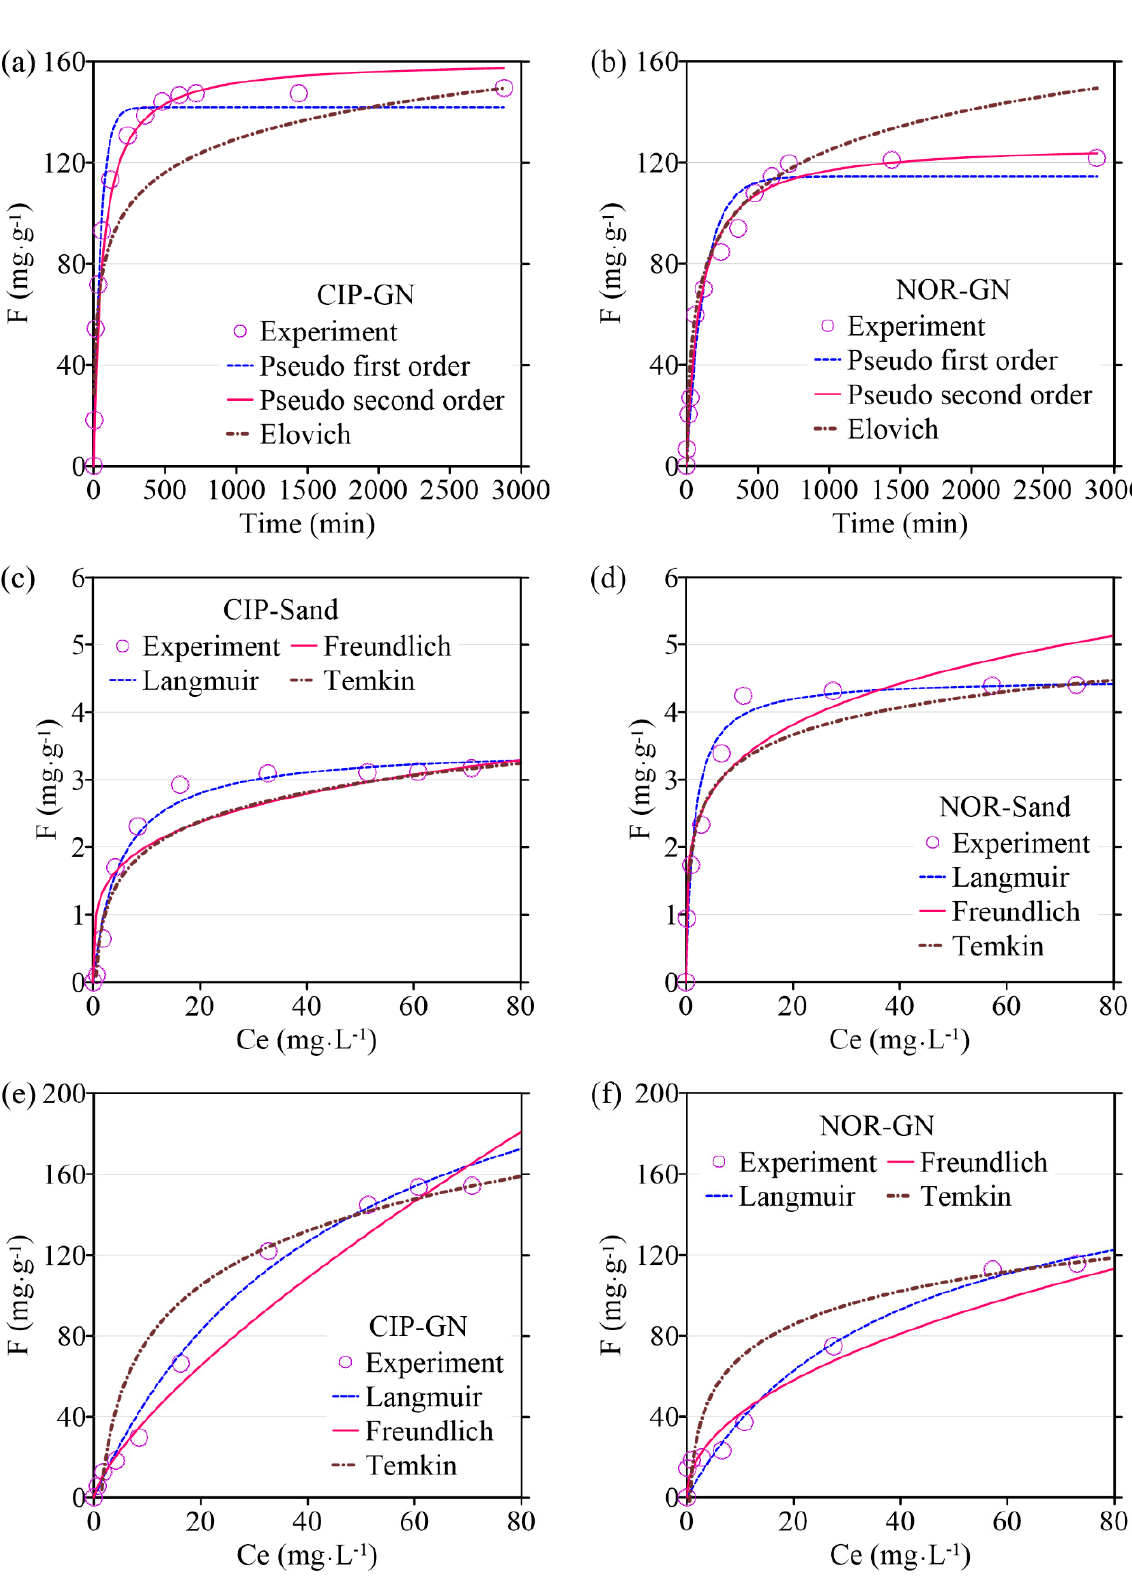
Figure 2. Adsorption kinetics of QNs onto GN and SS: ( a ) adsorption kinetics of CIP onto GN; ( b ) adsorption kinetics of NOR onto GN; ( c ) adsorption isotherm of CIP onto SS; ( d ) adsorption isotherm of NOR onto SS; ( e ) adsorption isotherm of CIP onto GN; ( f ) adsorption isotherm of NOR onto GN.